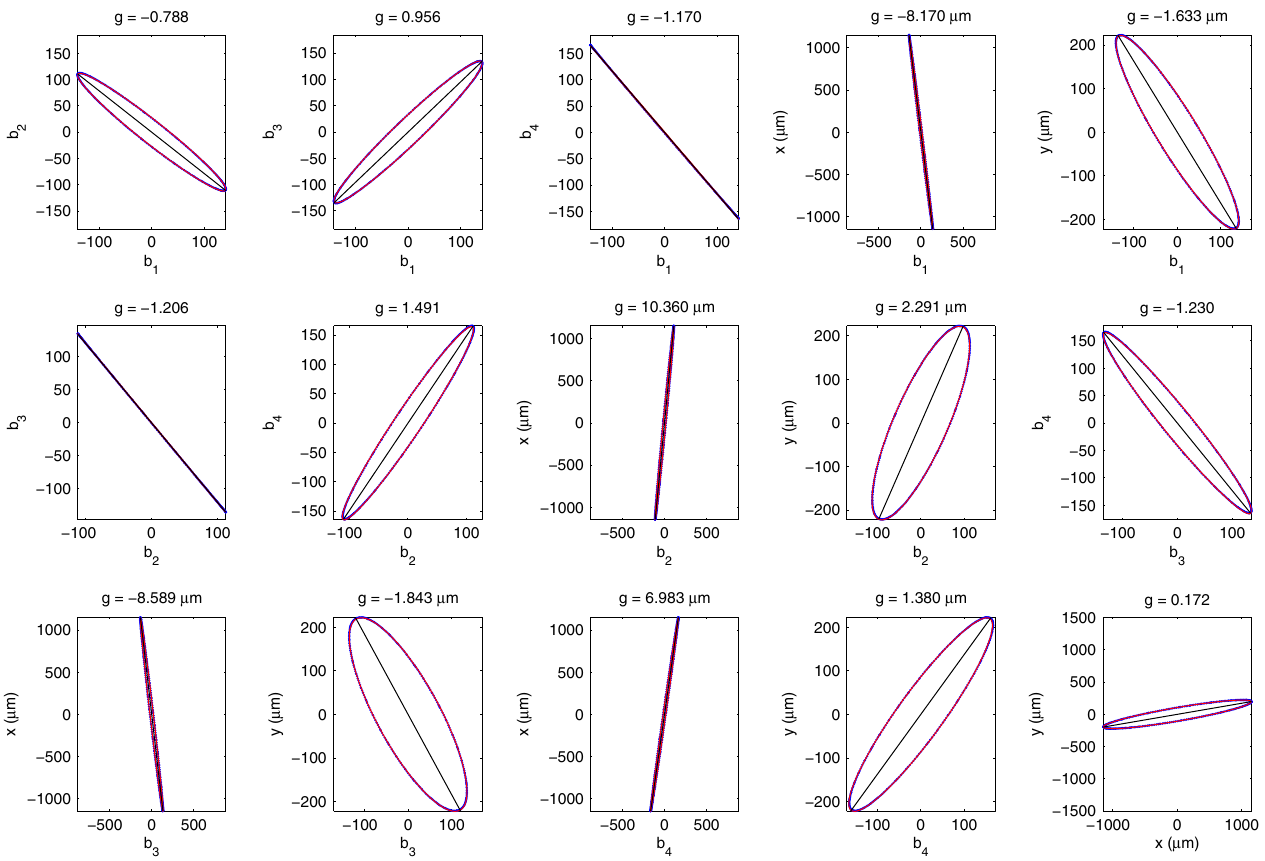
FIG. 4. As Fig. 3, but with skew quadrupole 48W turned on with strength k ¼ (cid:1) 0 : 023 m (cid:1) 2